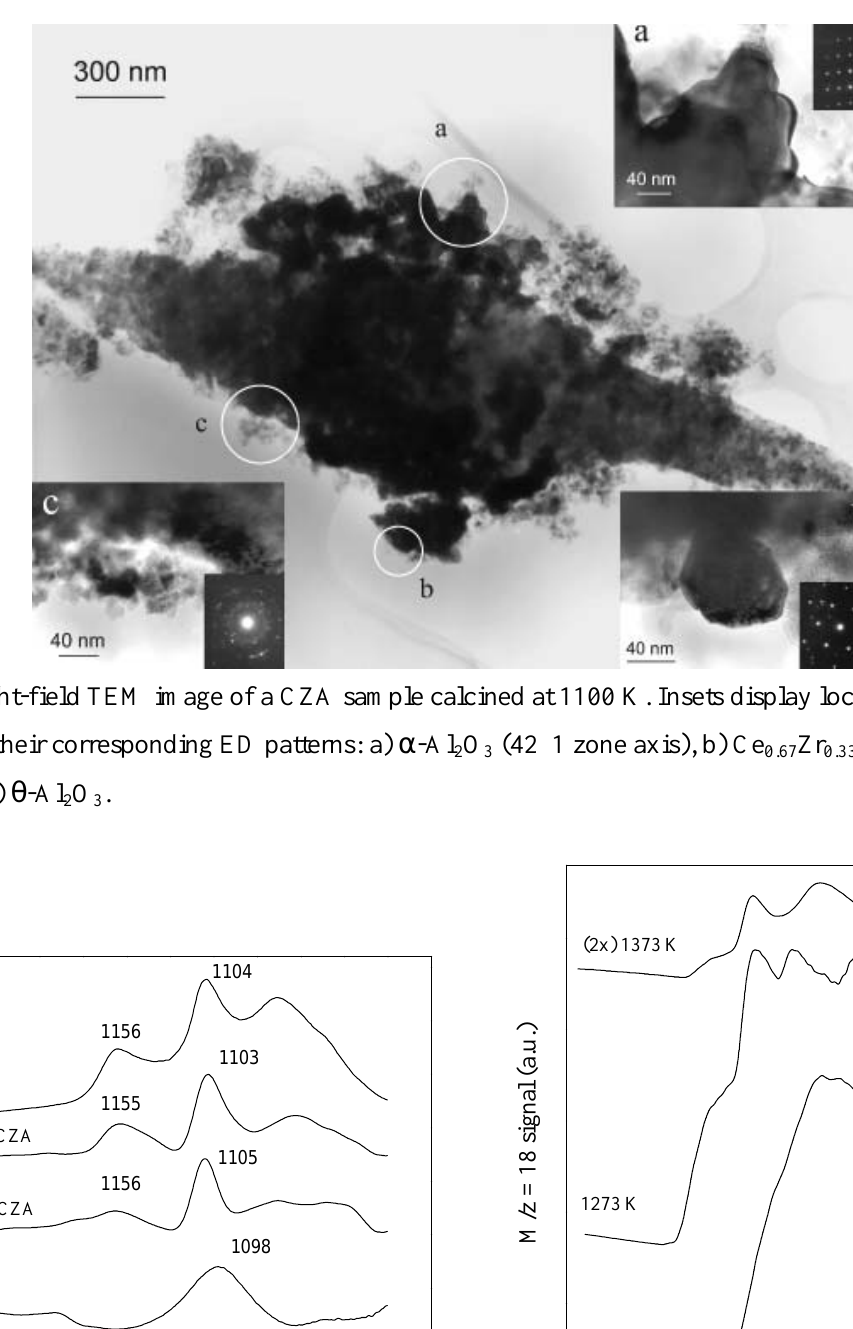
Fig. 3 FTIR spectra after methanol adsorp- tion on samples outgassed at 773 K, fol- lowed by outgassing at 373 K. CZA samples have the alumina contribution subtrated.